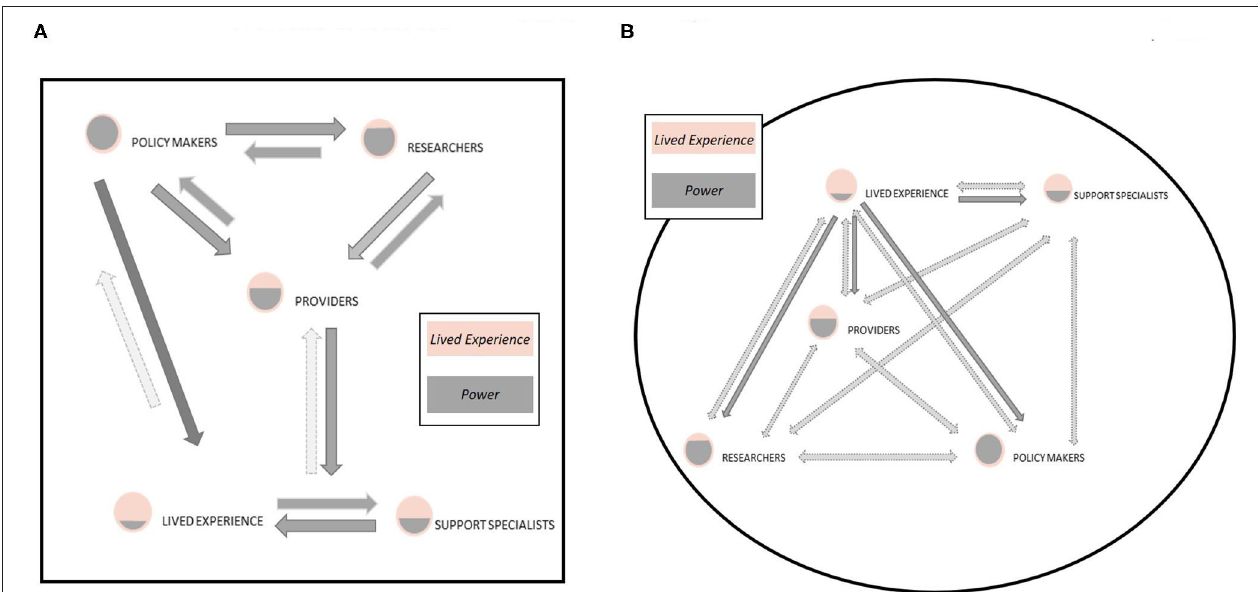
FIGURE 1 | Model of (A) traditional sources of influence and contributors to research, often policy makers (including funding agencies) and researchers. This reflects a top-down, hierarchical model of power and privilege in the design, dissemination, and implementation of research outcomes. In this model, individuals with lived experience often have the least direct contribution to research yet are impacted the most by the direct products and dissemination (or lack therefore) of research. In contrast, we present a new model (B) that enhances the voice of individuals with lived experience in the research process and suggests a more bidirectional and inclusive model. Elevating the role of individuals with lived experience within the research process provides valuable insight to ensure the research process is inclusive, research aims are reflective of actual need, and research products address questions and weaknesses that the research community and policy makers have overlooked or